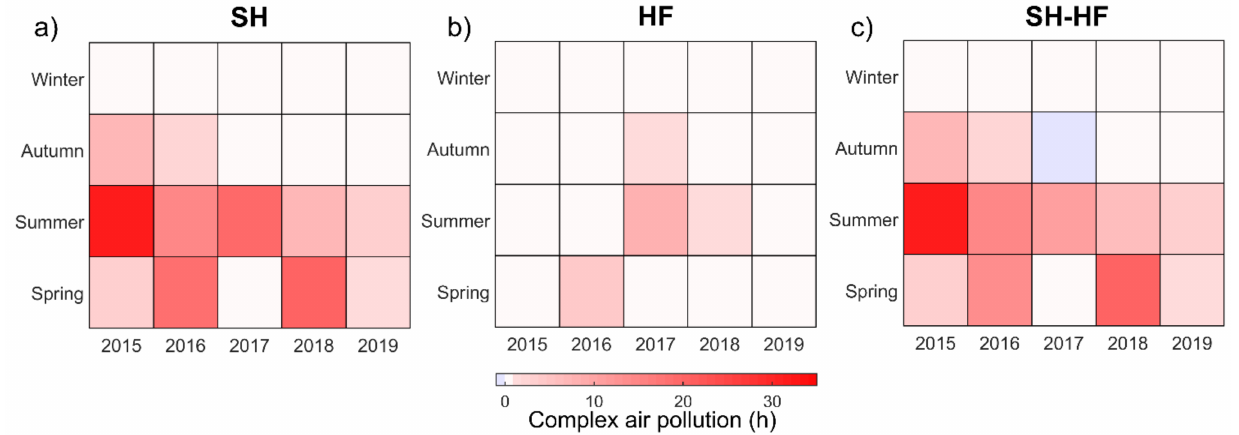
Figure 3. Joint histograms of seasons and years for complex air pollution hours for ( a ) SH, ( b ) HF and ( c ) SH–HF. SH–HF denotes the differences of complex air pollution hours between SH and HF. Abbreviations: SH—Shanghai;